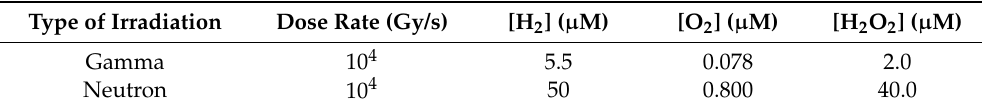
Table 14. Concentrations of H 2 , O 2 , and H 2 O 2 predicted by [27] by gamma and neutron irradiation at equivalent dose rates of 10 4